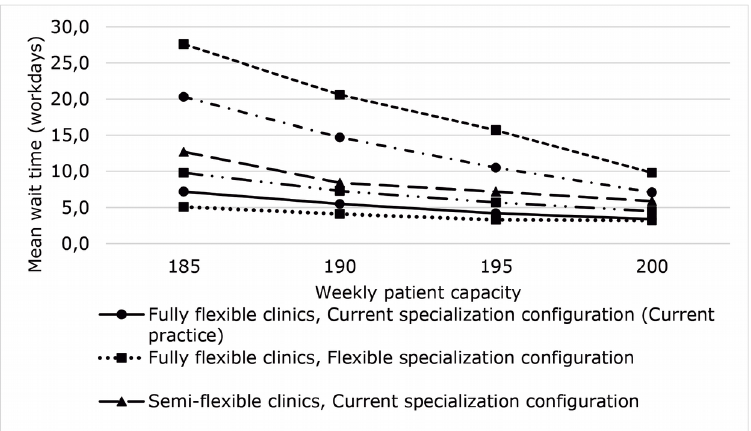
Figure 4. Effect of clinic flexibility and specialization configuration on patient